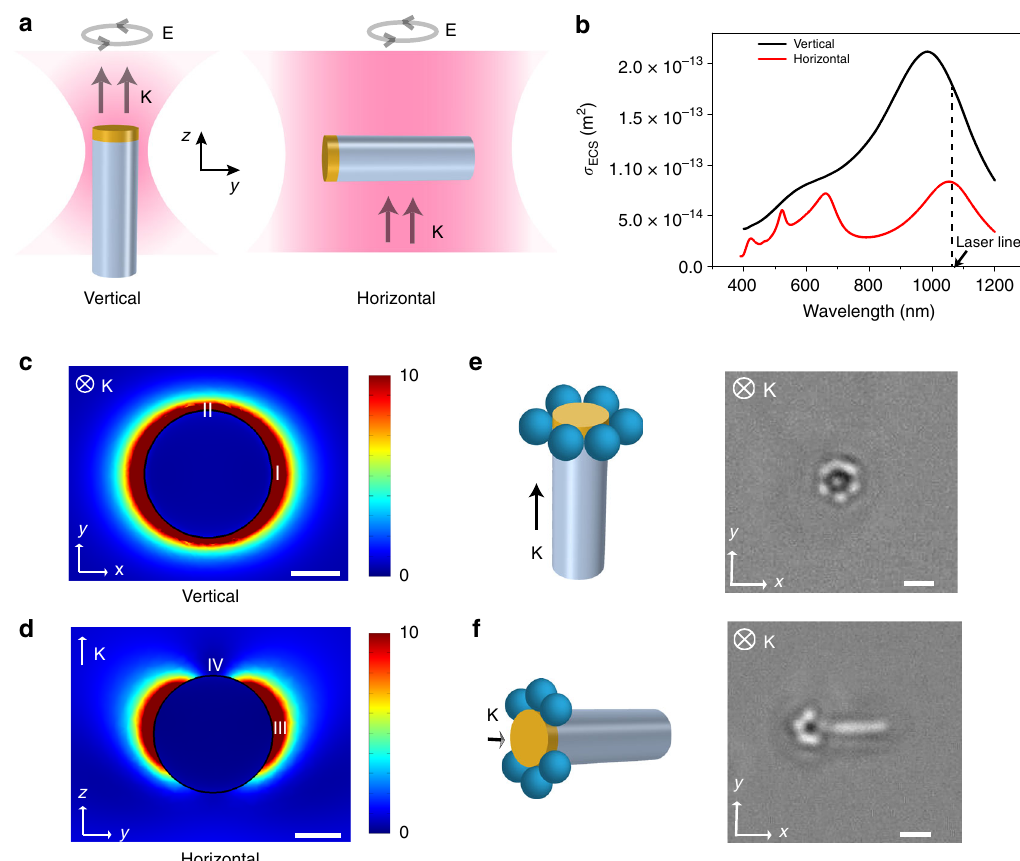
Fig. 4 Trapping con fi gurations. a Different orientations of ACT for elliptically polarized laser beam propagating along z -axis. With a tightly focused laser spot, the ACT aligns with the propagation direction resulting in a vertical con fi guration. Increasing the spot size causes the ACT to prefer a horizontal con fi guration while remaining trapped loosely within the illuminated region. b Extinction cross section vs wavelength for 250 nm silver nanodisks for vertical and horizontal con fi guration. c , d Enhancement of electric fi eld for the nanodisks in vertical con fi guration and horizontal con fi guration under 1064 nm illumination. Both scale bars are 100 nm. e , f Trapping of 400nm PS particles in plasmonic near- fi eld for vertical and horizontal con fi guration. Both Scale bars are 1 μ